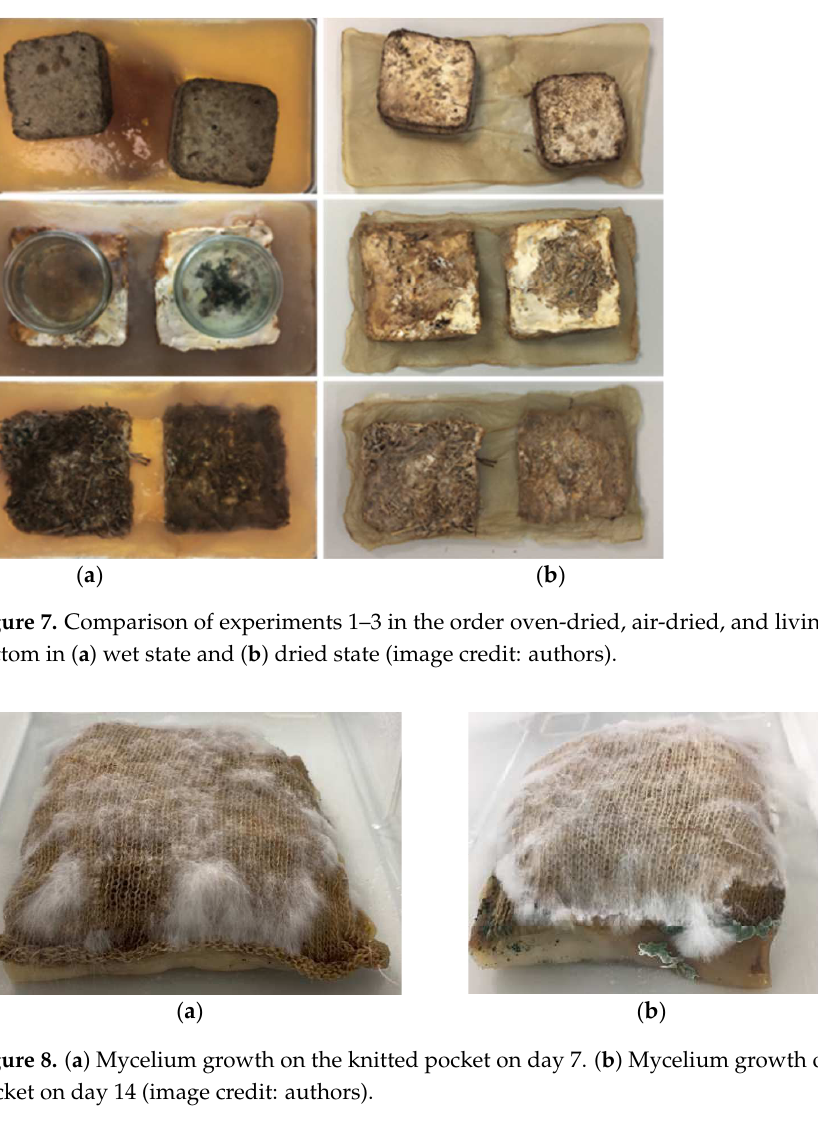
Figure 8. ( a ) Mycelium growth on the knitted pocket on day 7. ( b ) Mycelium growth on the knitted pocket on day 14 (image credit: authors).